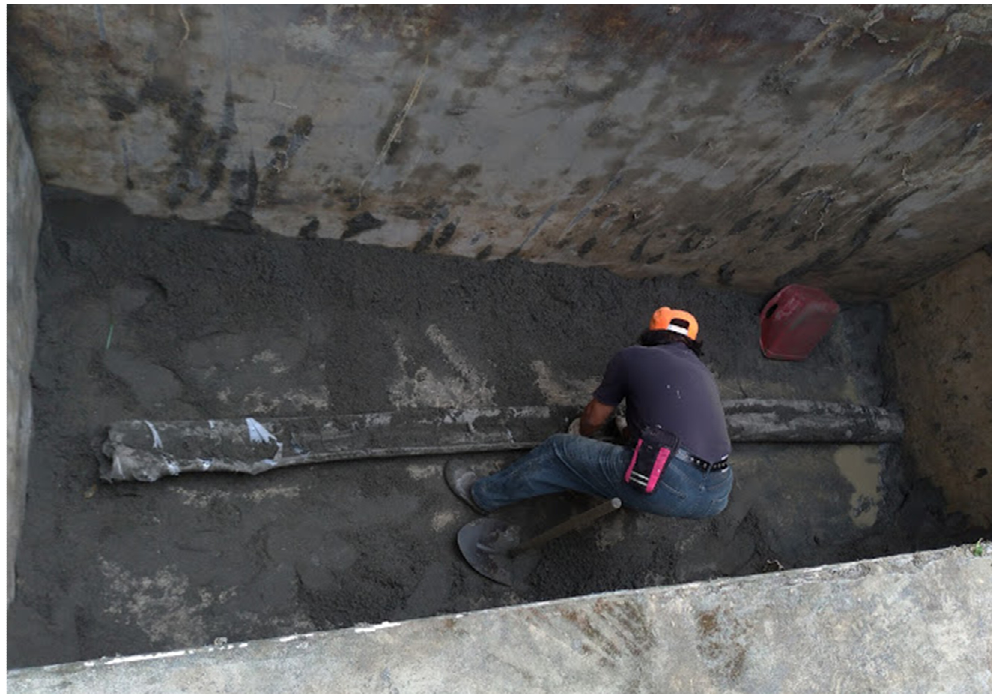
Figure 7. The broken drainage pipe after experiments.